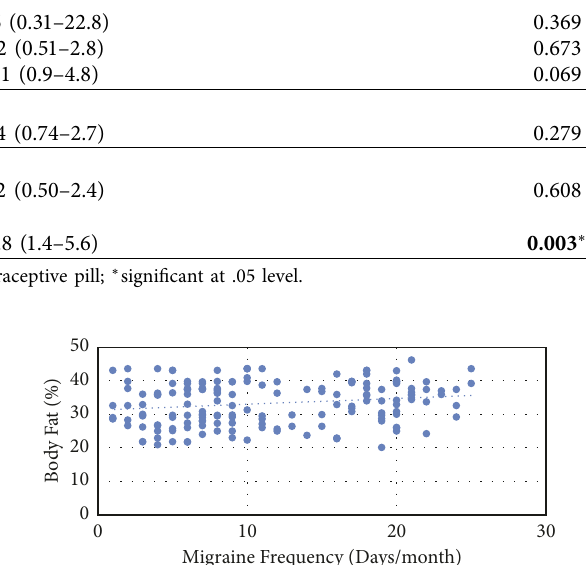
Figure 1: The graph depicts the relation of increasing body fat percentage with increase in migraine